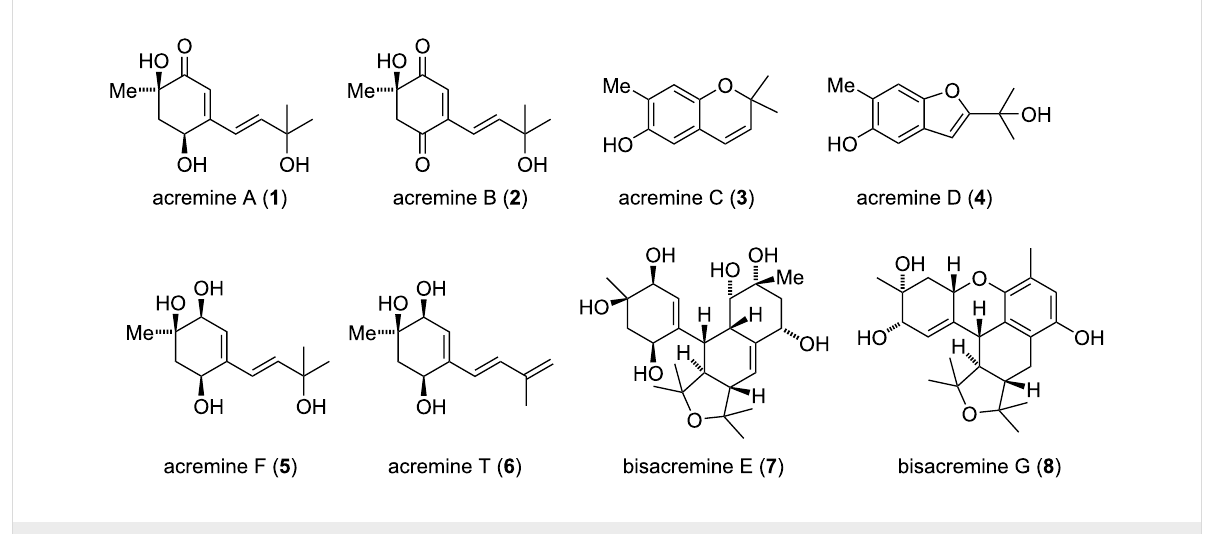
Figure 1: Selected members of the acremine family [3-5].